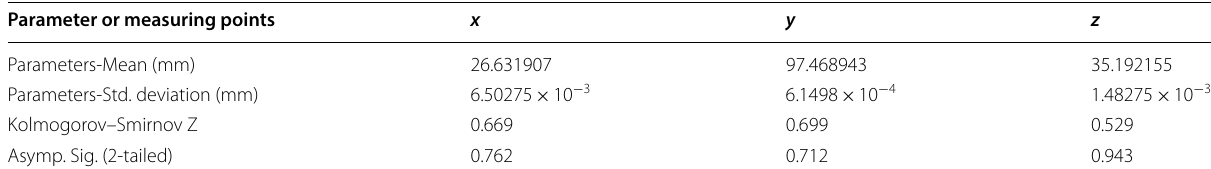
Table 4 One-Sample Kolmogorov–Smirnov test Parameter or measuring points